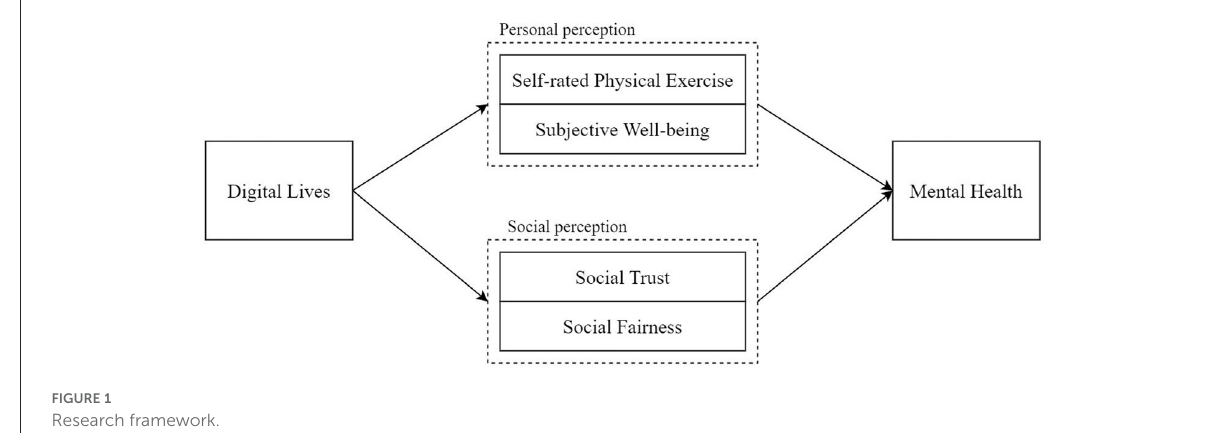
FIGURE1 Research